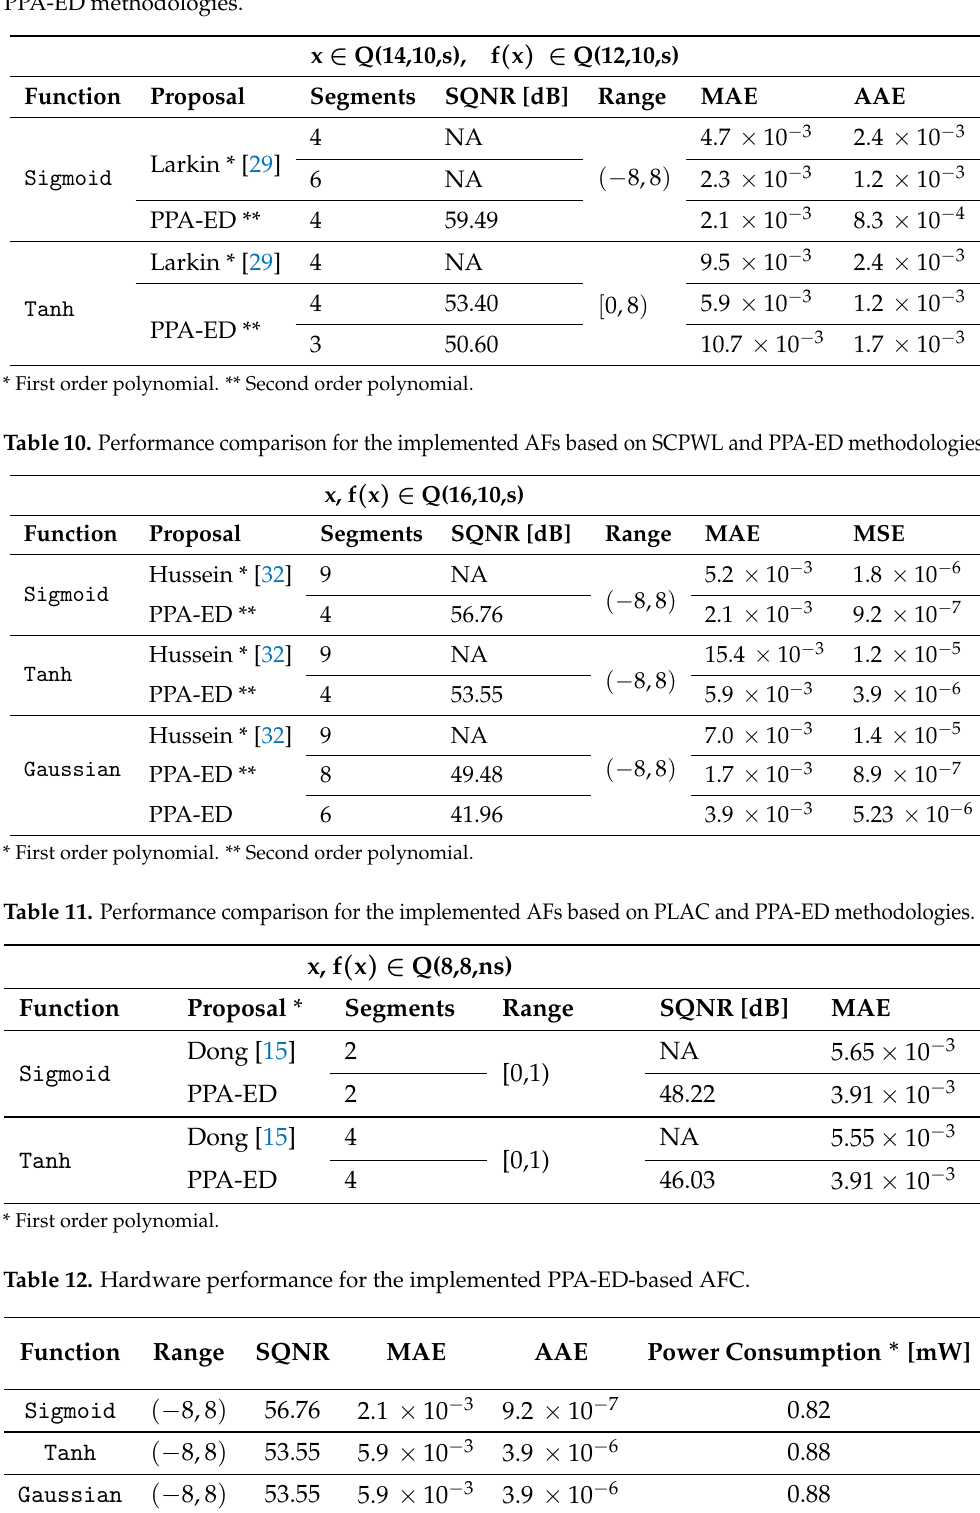
Table 9. Performance comparison for the implemented AFs based on minimax approximation and PPA-ED methodologies.